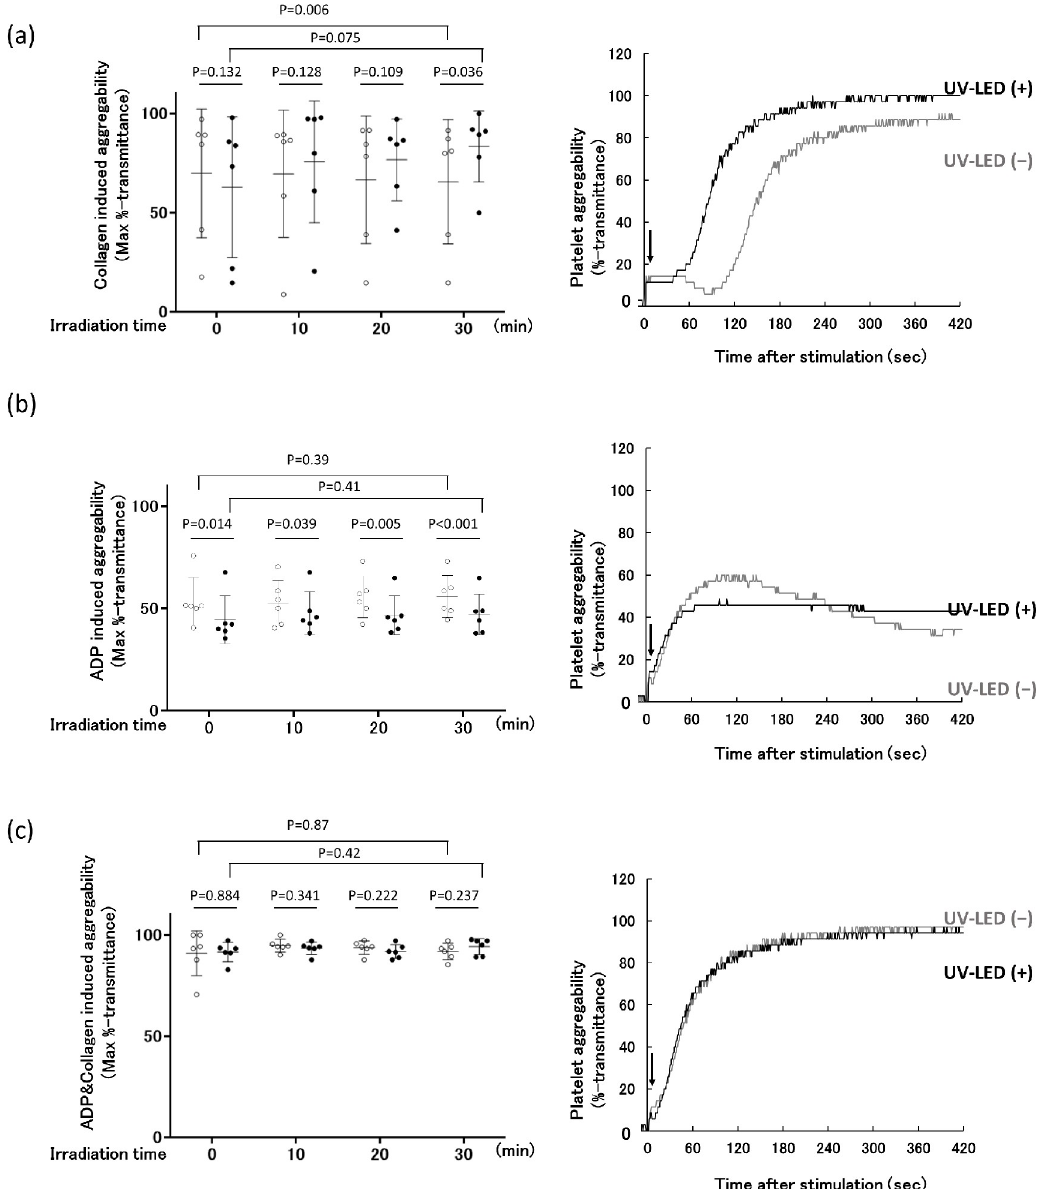
Fig 5. Effect of UV-LED irradiation on agonist-induced platelet aggregation. (a) Platelet aggregation induced by collagen (final concentration, 5 μ g/mL), (b) ADP (final concentration, 20 μ M), and (c) a mixture of ADP and collagen (final concentrations of 5 μ M and 2.5 μ g/mL, respectively) are shown. Six independent experiments of control (non-irradiated) and UV-LED-irradiated samples are displayed as open and closed circles, respectively. Mean values ± SD are shown as one long and two short horizontal bars. Based on the mean absorbance of PC samples, irradiation times of 10, 20, and 30 min correspond to fluence values of 9.1, 18.3, and 27.7 mJ/cm 2 , respectively. (a-c right panels) PCs were irradiated with UV-LED for 30 min. Platelets were then diluted as described in the Materials and Methods and stimulated with agonists at time 0 (arrow). Aggregation curves of irradiated (UV-LED (+)) and non-irradiated (UV-LED ( − )) platelets are displayed as black and grey lines, respectively. Representative data are